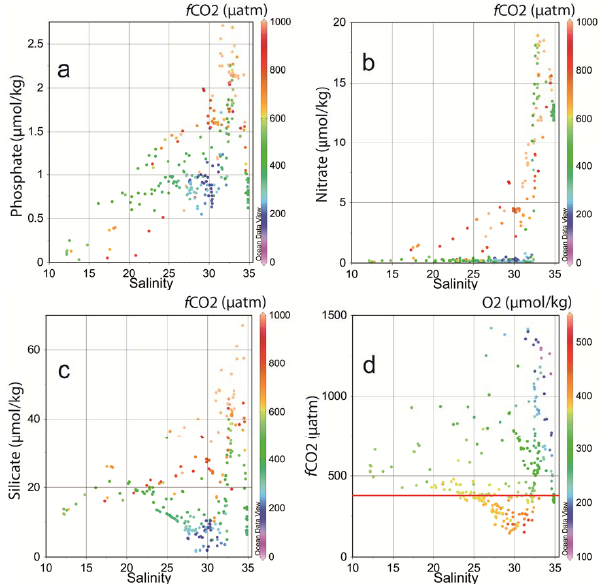
553 Fig. 7 . Plots of phosphate (a), nitrate (b) silicate (c) and f CO 2 (d) versus salinity for all 554 Fig. 7. Plots of phosphate (a) , nitrate (b) silicate (c) and f CO 2 samples collected in the East Siberian Sea. The color symbols in the nutrient plots illustrate 555 (d) versus salinity for all samples collected in the East Siberian Sea. the f CO 2 values, while the color in the f CO 2 plot illustrate the oxygen concentration. In the 556 The color symbols in the nutrient plots illustrate the f CO 2 values, latter the atmospheric level at the time of the investigation is illustrated with the horizontal 557 while the color in the f CO 2 plot illustrate the oxygen concentra- line at 375 - 380 µatm. 558 tion. In the latter the atmospheric level at the time of the investiga- tion is illustrated with the horizontal line at